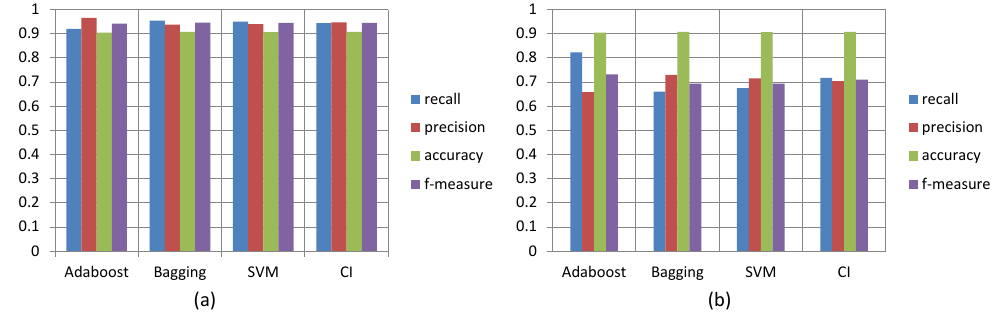
Figure 9. Precision, recall, accuracy and f-measure of four classification algorithms ( a ) for detecting normal events and ( b ) for detecting unusual